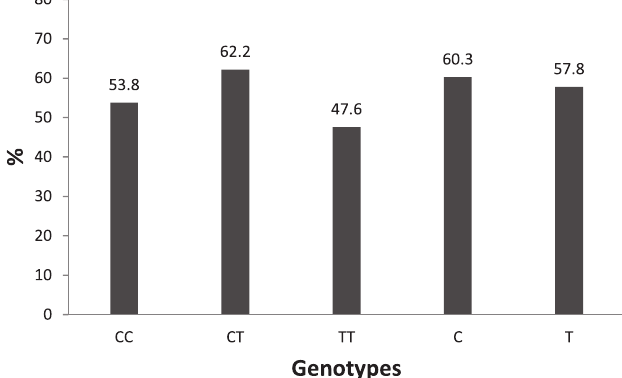
FIGURE 1 - Cessation rates by genotype